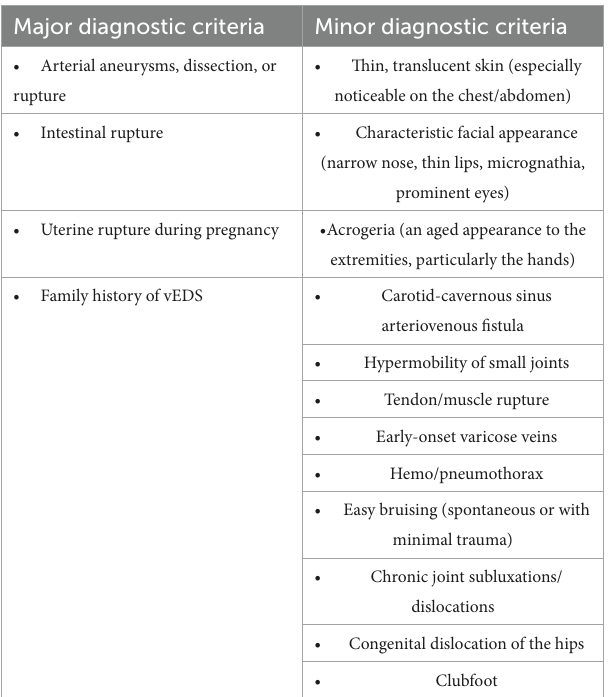
TABLE 1 Major and minor diagnostic criteria for vEDS